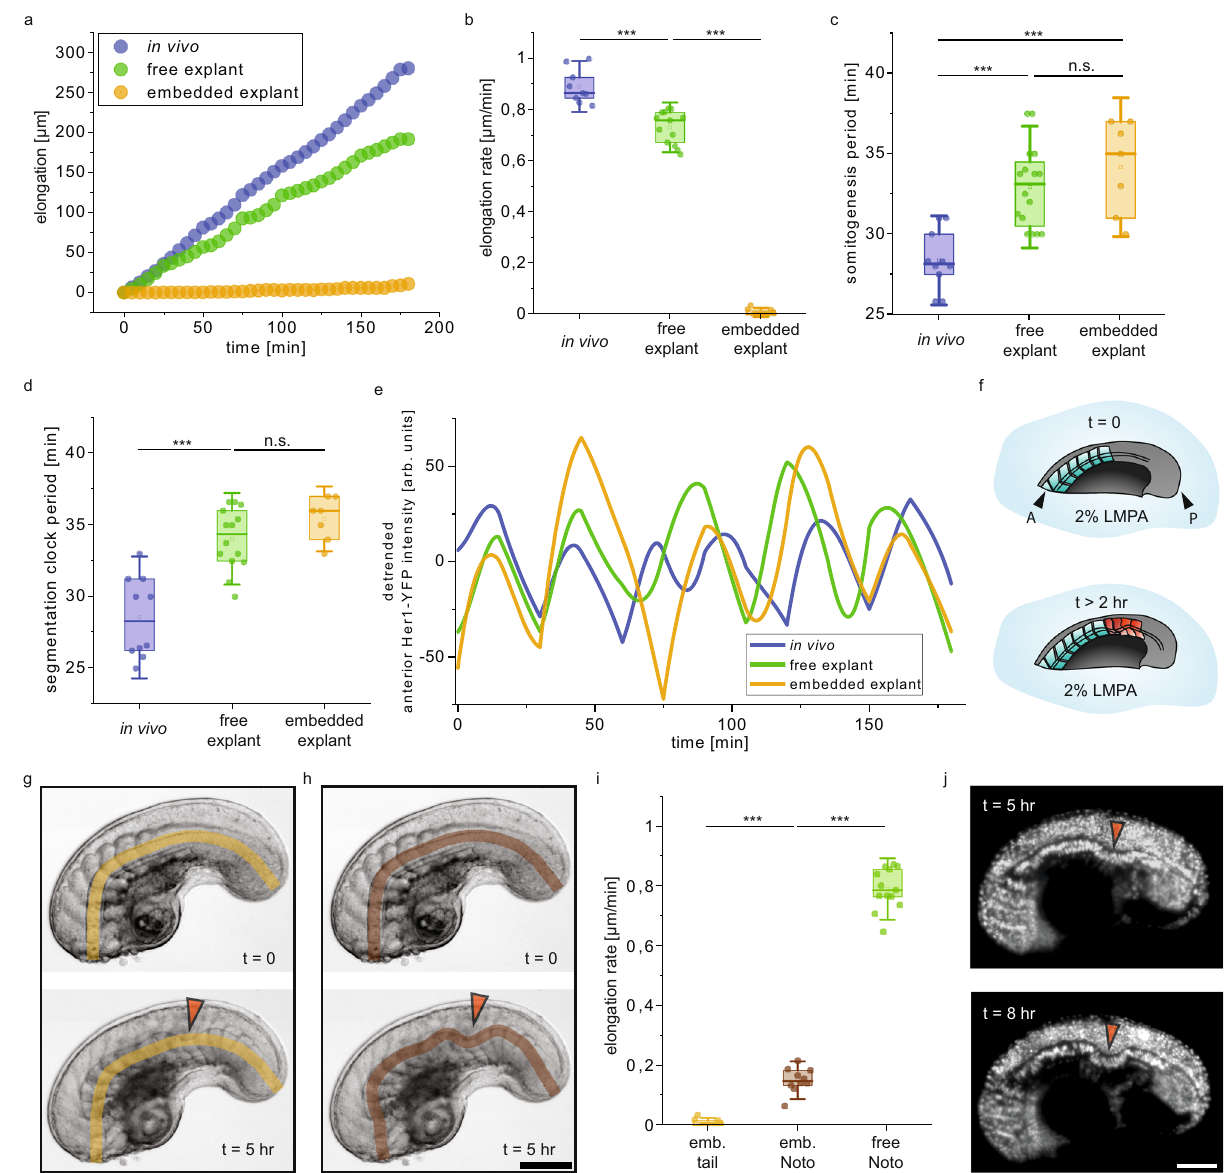
Fig. 2 | Embedding of explants dissociates notochord elongation and tail morphogenesis. a Representative elongation vs time curves for in vivo embryos, andexplantsthatarefreetoelongateorembeddedinsideagarosegel. b Elongation rates extracted from elongation vs time curves, such as shown in ( a ) ( N =4, n =9 embryos, N =4, n =13 free explants, N =3, n =10 embedded explants). c Average period of somitogenesis in intact embryos ( N =4, n =10), free tail explants ( N =4, n =16), and embedded tail explants ( N =2, n =7). d Average period of Her1-YFP oscillations in intact embryos ( N =4, n =10), free tail explants ( N =4, n =14), and embedded tail explants ( N =2, n =7). e Representative plots showing the intensity ofHer1-YFPsignalovertime.Thesignalisrecordedintheanteriorpartoftheintact embryos,freetailexplantandembeddedtailexplants. f Schematicshowingthetail explant embedded in 2% LMPA (low melting point agarose). Embedding leads to structural defects in the somites and the notochord (A: anterior, P: posterior).